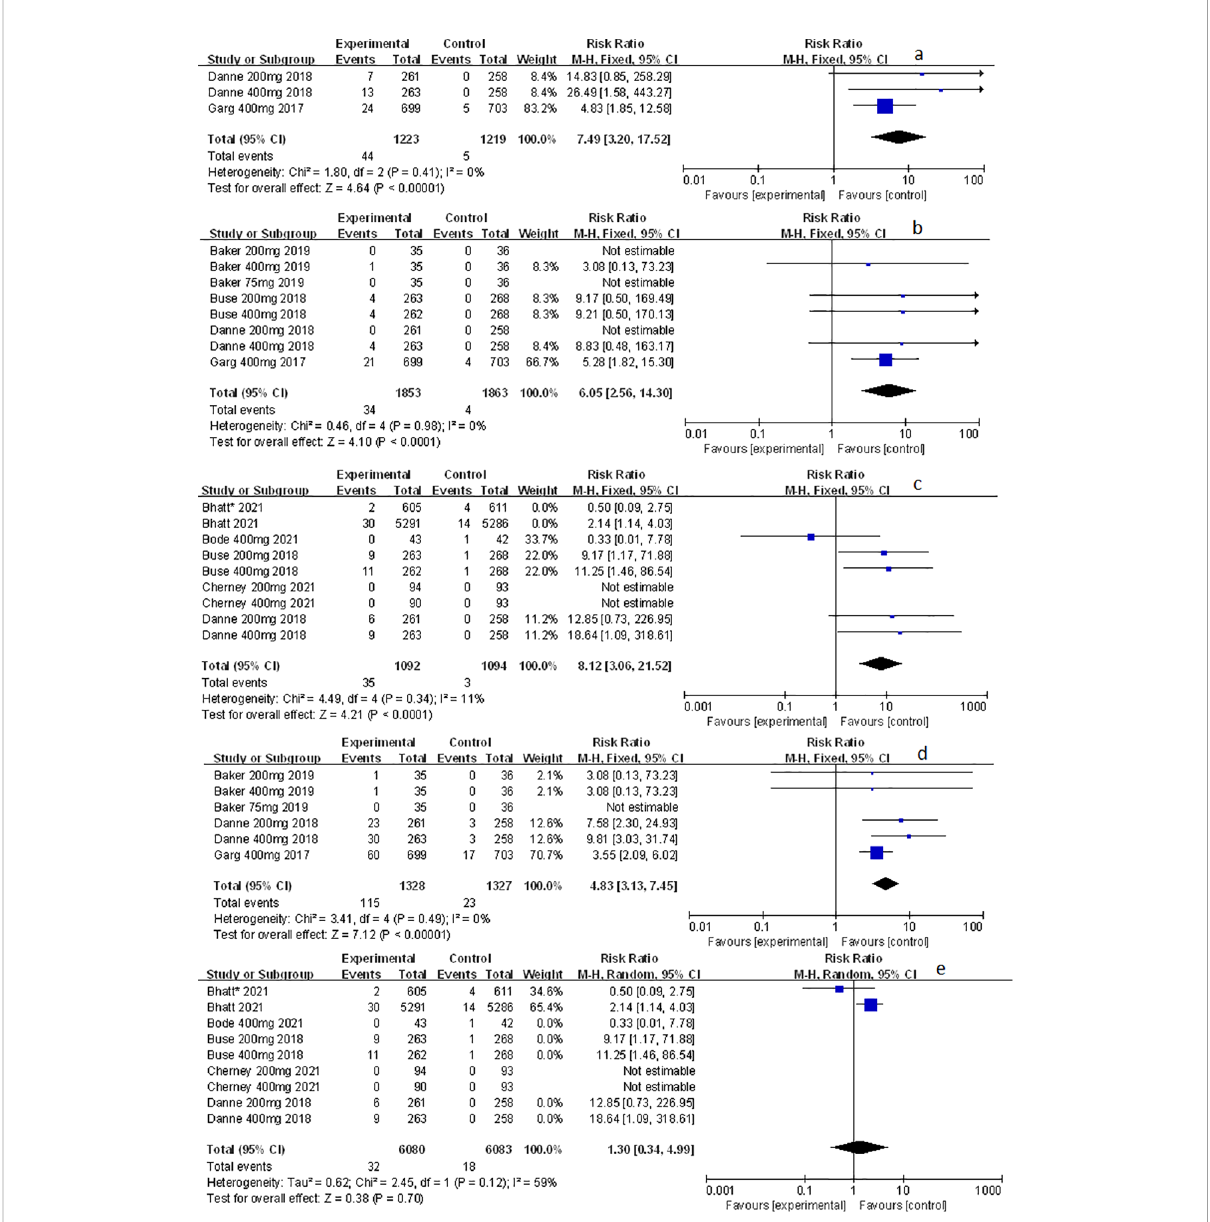
FIGURE 3 Forest plot of related to acidosis events for sotagli fl ozin versus the control group in T1D and T2D. (A) The adverse events of severe acidosis- related adverse events in T1D. (B) The adverse events of positively adjudicated DKA in T1D. (C) The adverse events of DKA in T1D. (D) The acidosis-related adverse events in T1D. (E) The adverse events of DKA in